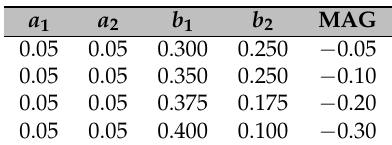
Table 2. Parameter values for simulation of the linear trends in Equation (8) to compare JUST with the OLS-based method for jump